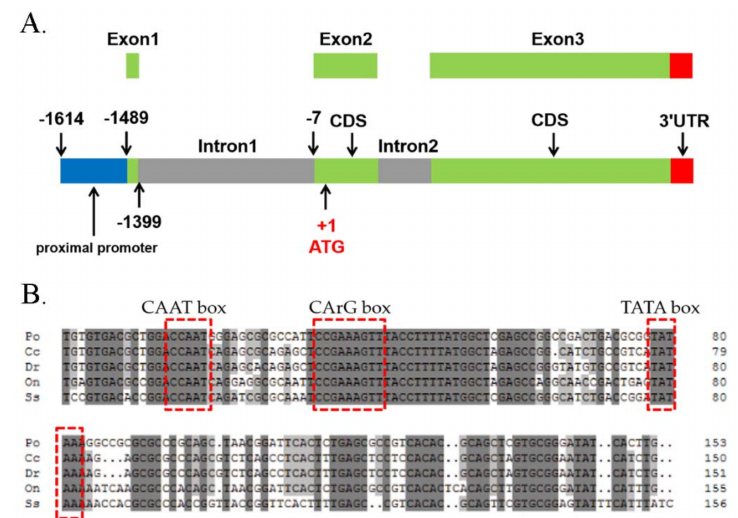
Figure 1. Nucleotide sequences of the fragment of Japanese flounder ( Paralichthys olivaceus ) β -actin gene. ( A ) A schematic map of the genomic sequence of flounder β -actin and the 5 (cid:48) -flanking sequences. The numbers indicate the positions (the first base of starting codon ATG was set as position +1). ( B ) Sequence alignment of the proximal promoter region is shown. Red and open boxes mark conserved sequences and known factor binding sites, respectively; CAAT-box, CArG motif, and TATA boxes.